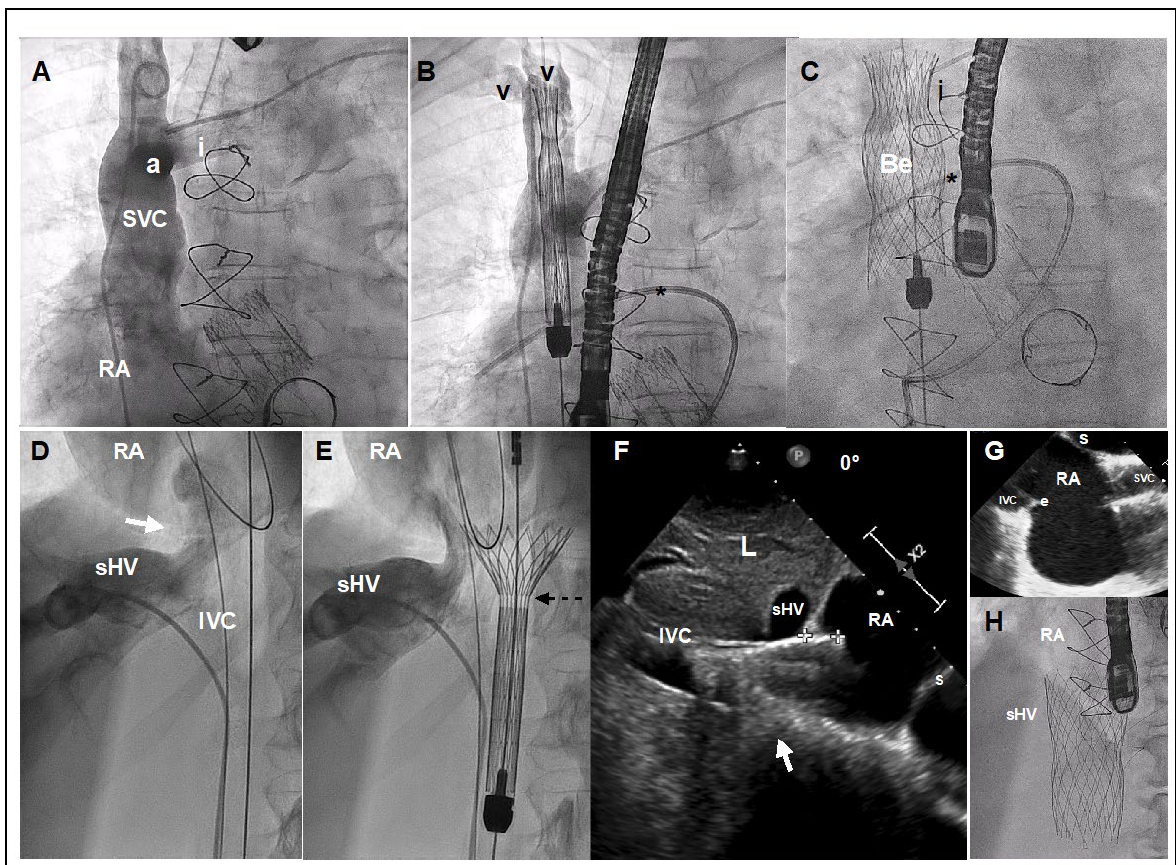
Figure 5. TricValve ® implant details. ( A ) Venogram of the SVC with careful visualization of the innominate vein (i). The venogram was performed using a dual injection technique, 1 using a pig-tail through left femoral access, and another using a multipurpose through left basilica vein access. ( B , C ) Target position is to implant the belly part of the device (segment with higher radial force) at the level of pulmonary artery plane or between pulmonary artery plane and confluence with the innominate vein. A Swan-Ganz catheter placed into the right pulmonary artery and multipurpose catheter (or leads if patient has a pacemaker) may be a helpful reference. ( D ) Venogram with careful visualization of the right supra-hepatic vein confluence, IVC and junction with the right atrium (white arrow). ( E ) The first 20 mm of the proximal edge of the inferior valve is covered by a skirt to prevent occlusion of the hepatic vein. A radiolucent mark shows where the skirt of the valve ends (broken arrow). ( F ) TEE at 0º, showing the inferior prosthesis during deployment entering 11 mm into RA (between crosses). White arrow shows the cavo-atrial junction. Optimally positioning requires only 5 to 12 mm of the proximal portion should enter into the RA. ( G ) TEE bi-caval view after deployment of the superior and inferior prosthesis. ( H ) Angiographic view of the inferior vena cava prosthesis immediately after deployment. a: Azygous confluence. Be: Belly part of the superior vena cava prosthesis. e: Eustachian valve. I: Innominate vein. IVC: Inferior Vena Cava. L: Liver. RA: Right Atrium. sHV: superior Hepatic Vein. s: Septum. V: Vein valves of Subclavian and Jugular veins. Star: Right Pulmonary Artery with Swan Ganz.